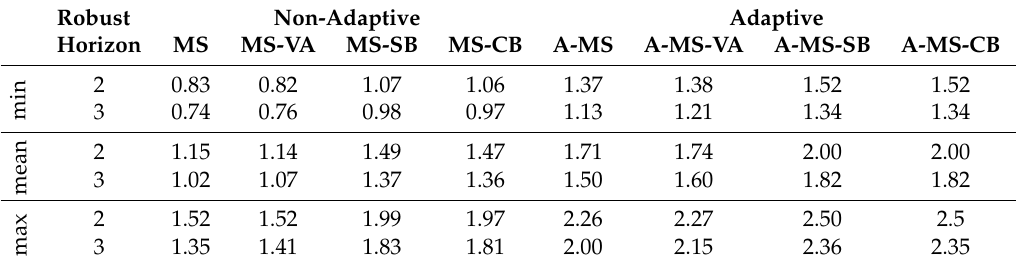
Table 5. Case study 1: Minimum (min), mean and maximum (max) number of moles of product C produced in the first 0.3 h using the non-adaptive and adaptive NMPC schemes with different lengths of robust horizon ( N r ) in the absence of measurement noise. A prediction horizon ( N p ) of length 5 is